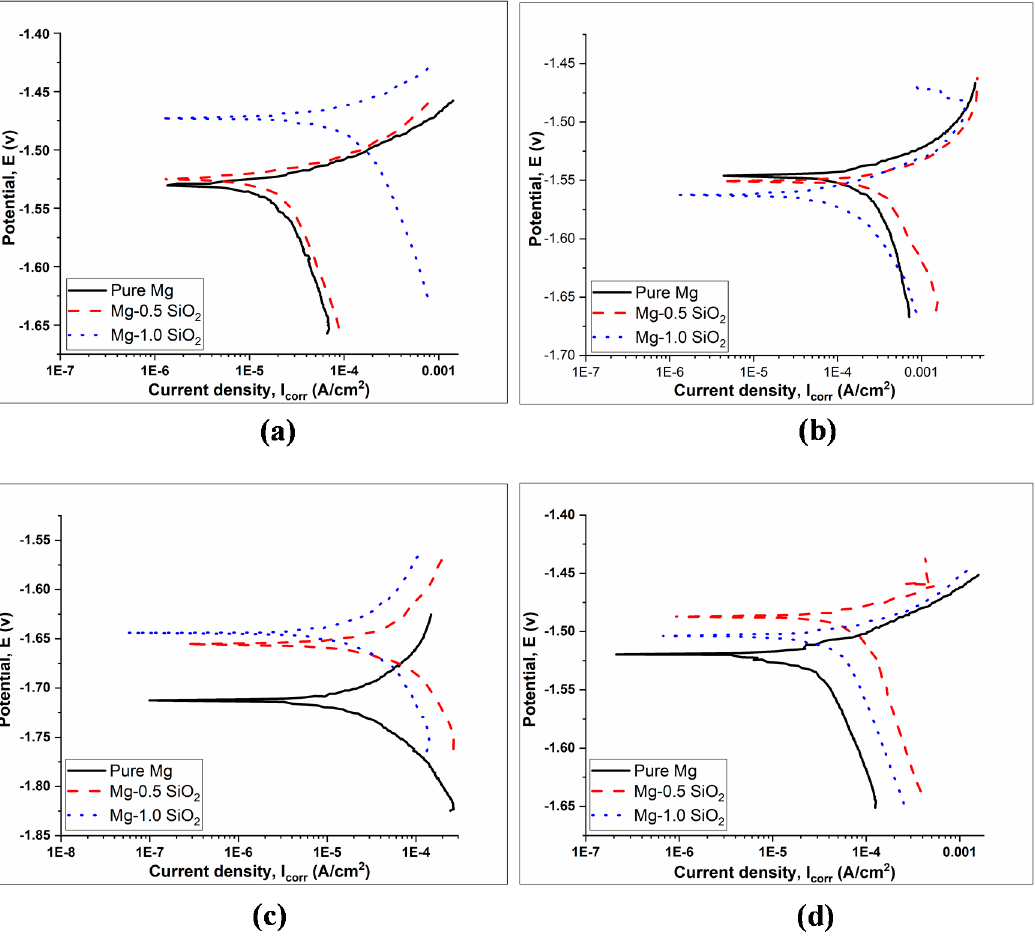
Figure 3. Polarization curves for pure Mg and Mg-SiO 2 syntactic foams in ( a ) artificial blood plasma solution (ABPS), ( b ) phosphate-buffered saline solution (PBS), ( c ) artificial saliva solution (ASS) and ( d ) Hanks’ balanced saline solution (HBSS) mediums.